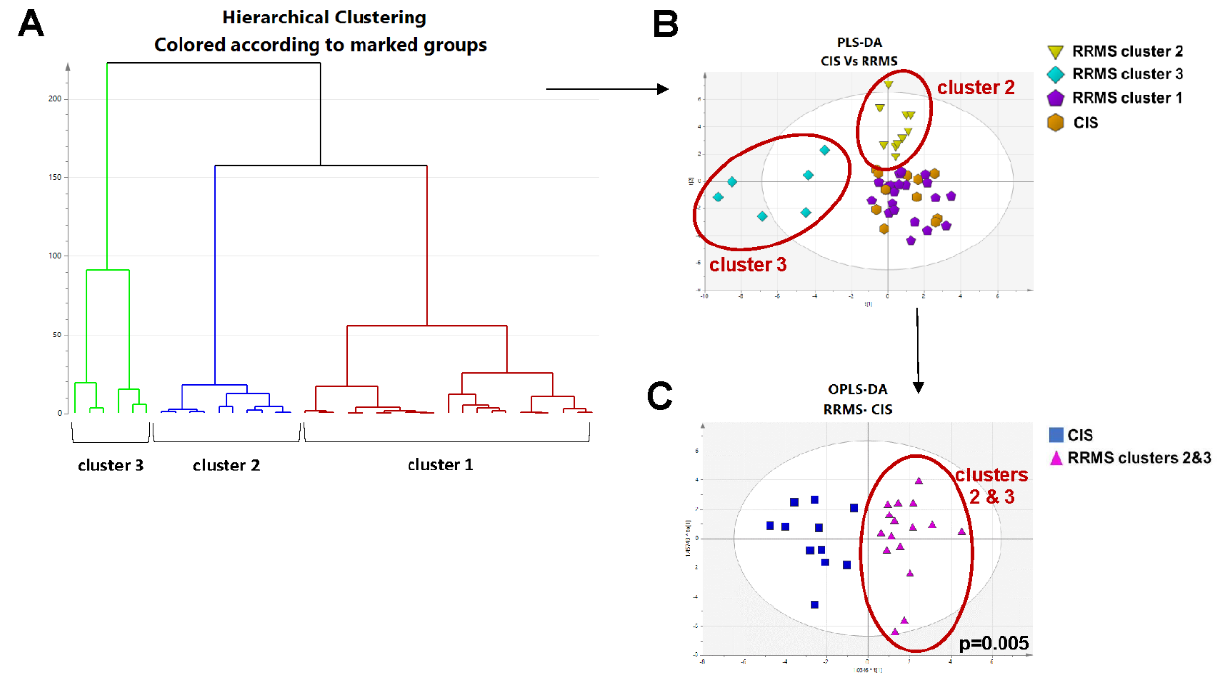
Figure 4. ( A ) Hierarchical Clustering Analysis dendrogram of samples from Relapsing-Remitting Multiple Sclerosis group using the original data and parameters from multivariate analysis (Principal Components Analysis model, 3 components: cluster 1 in red, overlapping with Clinically Isolated Syndrome, cluster 2 in blue and cluster 3 in green, UV scaling), ( B ) Projection to Latent Structures Discriminant Analysis (PLS-DA); observations (samples) are colored according to cluster from Hierarchical Clustering Analysis and symbol for cases with according to classes, where triangles in yellow represent cases with Clinically Isolated Syndrome, ( C ) Orthogonal Projection to Latent Structures Discriminant Analysis of Clinically Isolated Syndrome against Relapsing-Remitting Multiple Sclerosis clusters 2 and 3, following exclusion of Relapsing-Remitting Multiple Sclerosis cluster 1, that is, Relapsing-Remitting Multiple Sclerosis cluster overlapping to Clinically Isolated Syndrome. HCA: Hierarchical Clustering Analysis; PLS-DA: Projection to Latent Structures Discrimi- nant Analysis; OPLS-DA: Orthogonal Projection to Latent Structures Discriminant Analysis; RRMS: Relapsing-Remitting Multiple Sclerosis; CIS: Clinically Isolated Syndrome. PLS-DA was used as a mean to visualize samples and clusters after hierarchical clustering analysis. OPLS-DA was chosen for visualization of classification between the cluster 2 and 3 of RRMS samples and CIS